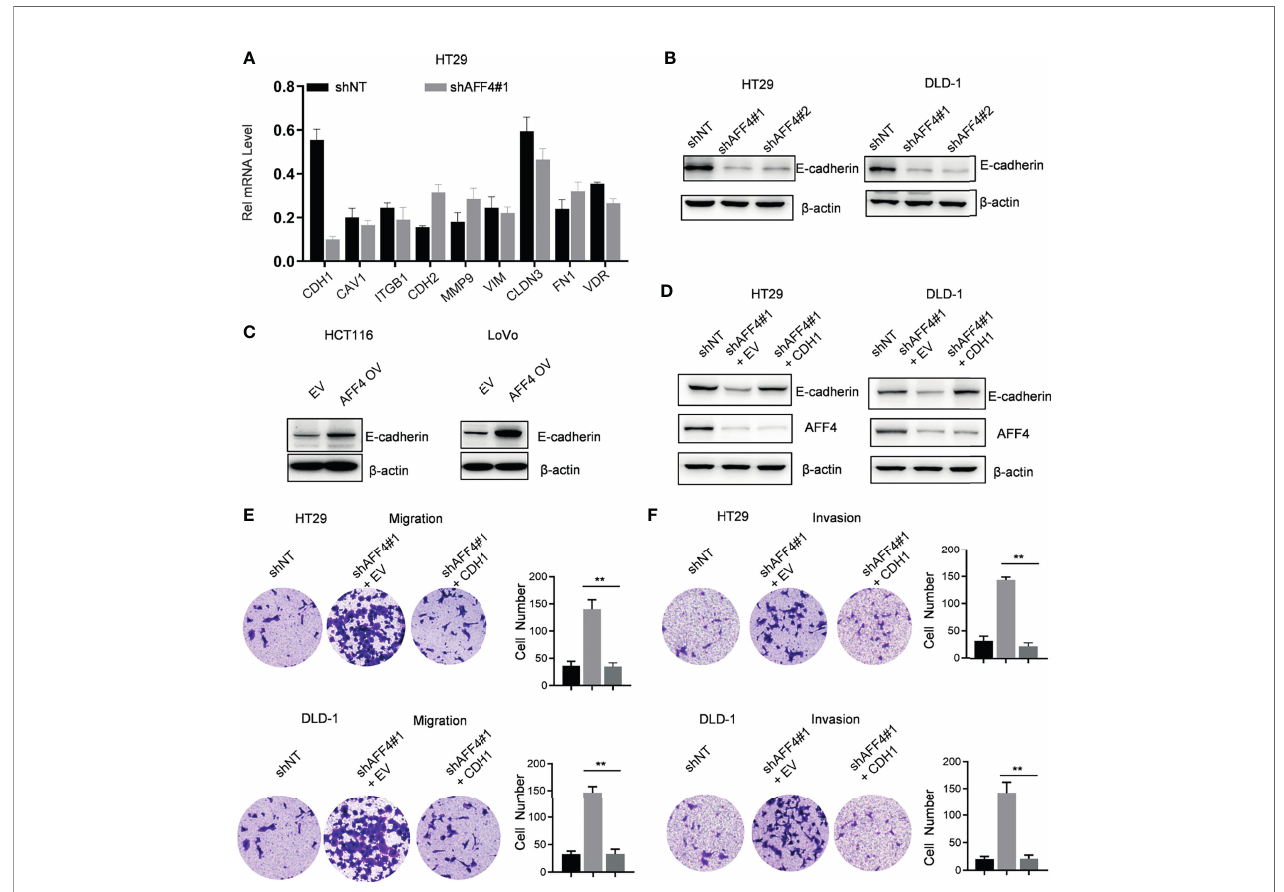
FIGURE 5 | AFF4 promotes CDH1 expression which impairs the cell migration and invasion in vitro . Data are from three independent experiments. Data are presented as the mean ± SD or SEM and are analyzed by unpaired t -tests or two-way ANOVA. ** p < 0.01. (A) A total of 9 genes related to cell migration or invasion were listed, and their gene expression were determined by qRT-PCR in the cell expression shNT or shAFF4#1. b -Actin was performed as an internal control. (B) Western blot assay was performed to test CDH1 expression in the HT29 or DLD-1 cells with or without AFF4. Sh, small hairpin; NT, nontarget. (C) Western blot assay was performed to test CDH1 expression in the HCT116 or LoVo cells with or without overexpression of AFF4. EV, empty vector, as a blank control; OV, overexpression. (D) Western blot was performed to test the successfully restored expression of CDH1 in the cells HT29 or DLD-1 cells with or without AFF4. (E, F) Cell migration or invasion was performed by seeding 50,000 HT29 and DLD-1 cells expressing shNT, shAFF4#1, or shAFF4#1 restored with CDH1 in the serum-free medium, and migrated (E) or invasive (F) cells through the 8- m m hole were fi xed by 80% cold methanol and stained by crystal